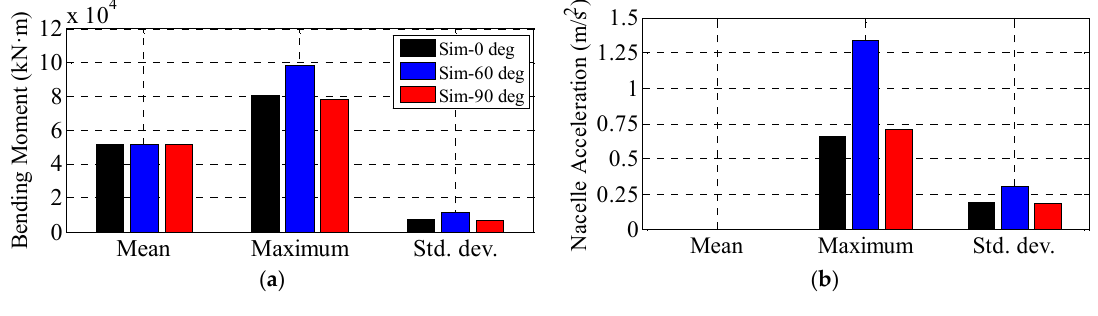
Figure 25. Statistical comparisons of ( a ) tower base bending moment and ( b ) nacelle acceleration between three aligned wind/wave directions.